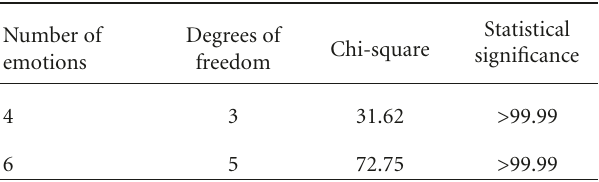
Table 10: Statistical significance for four and six emotions using glottal symmetry on 100 utterances of clean